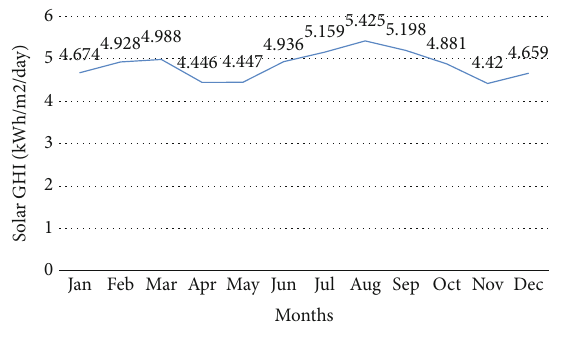
Figure 30: Monthly solar Global Horizontal Irradiation (GHI kWh/m 2 /day) for Burundi.